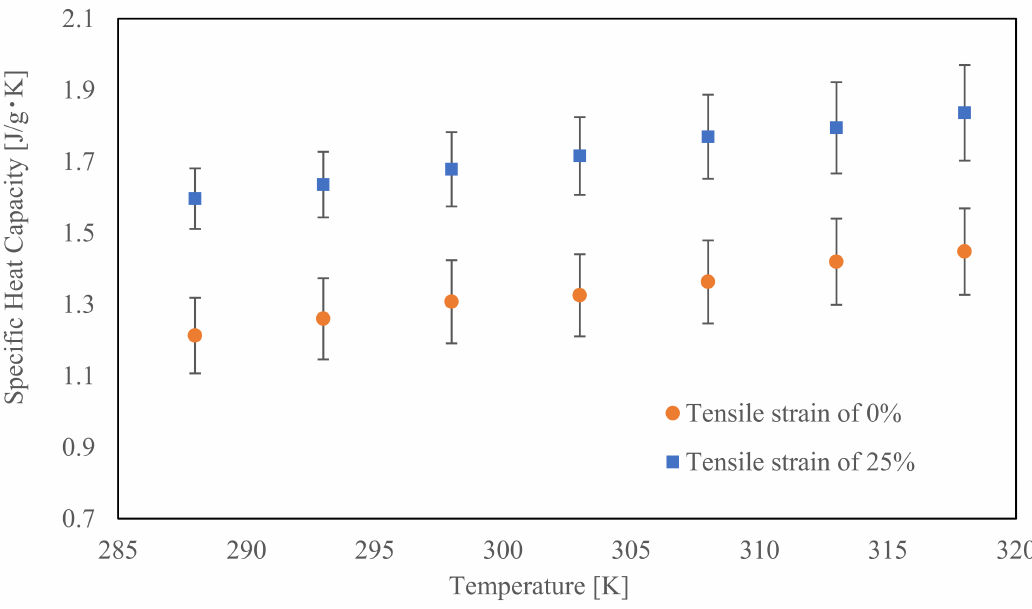
Figure 6. Relationship between the tensile strain and specific heat